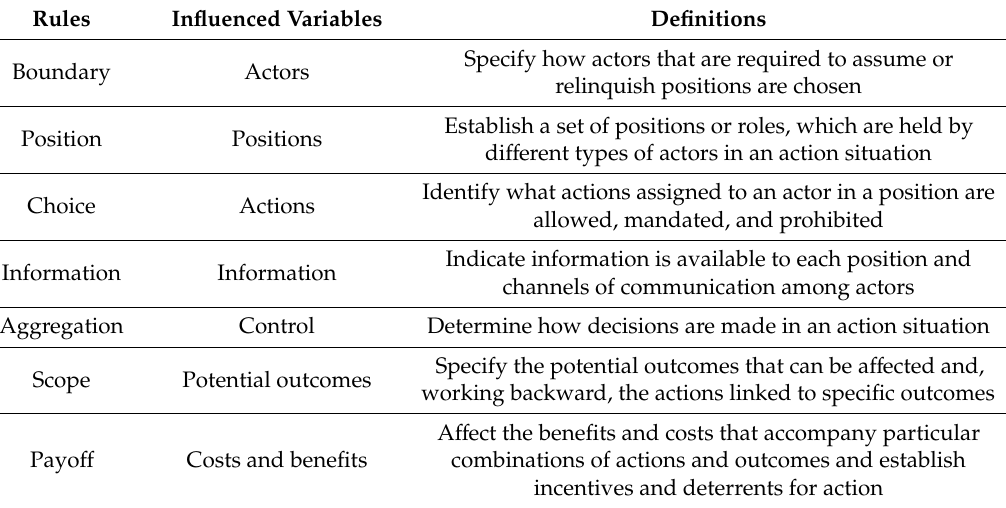
Table 2. Definitions of rules-in-use that define action